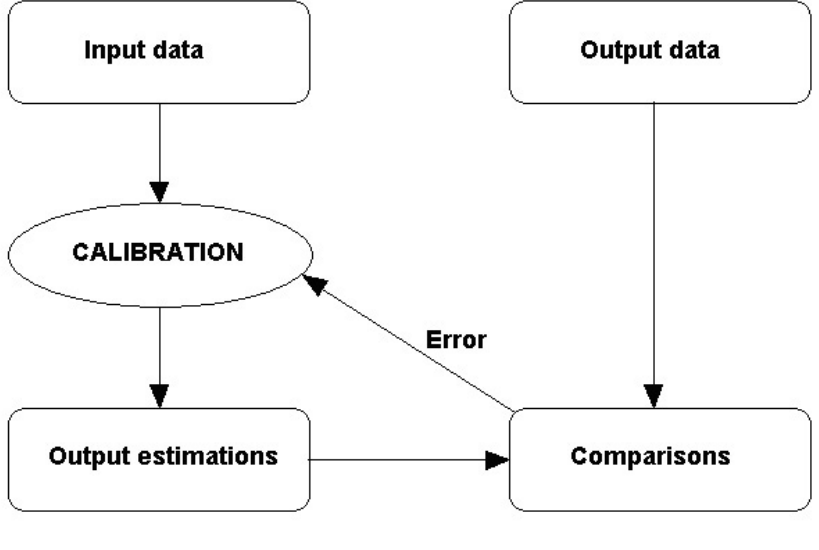
FIGURE 1. The diagram shows how data are used to establish the model calibration. The goal of the learning is to find a model that will as correctly as possible associate the input with the output data.